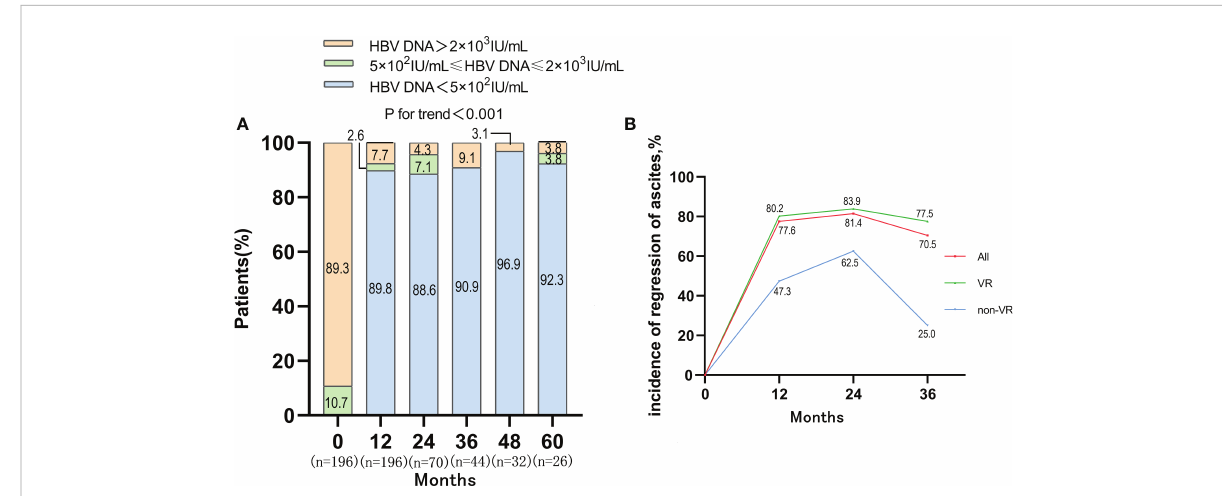
FIGURE 3 VR and the incidence of regression of ascites in VR and non-VR group in patients with fi rst decompensated HBV cirrhosis of ascites after NUC treatment. (A) Dynamic change of HBV DNA level after antiviral treatment; (B) Regression of ascites occurred with incidences of 77.6%, 81.4% and 70.5% in the whole cohort at 1, 2 and 3 years, and the VR cohort achieved a higher re-compensated rate than the non VR